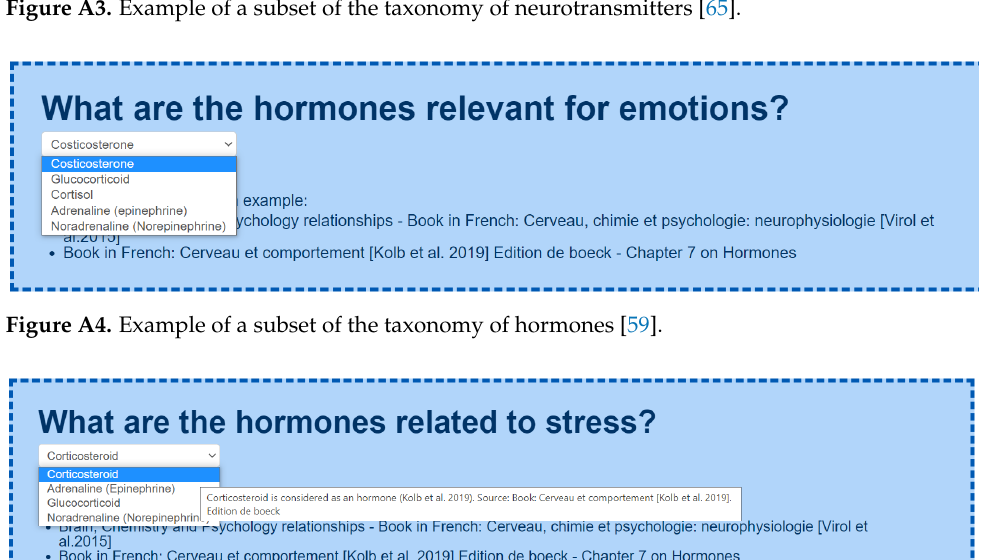
Figure A3. Example of a subset of the taxonomy of neurotransmitters [65].